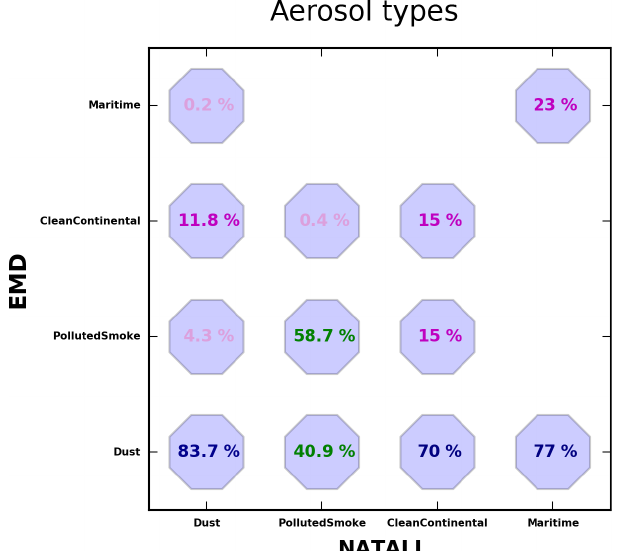
Figure 6. Typing score of each aerosol class derived by the EAR- LINET Mahalanobis distance-based typing algorithm (EMD) when applied to the NATALI modeled dataset (total of 259407 cases). The denominator in each column is the number of NATALI samples for a given type, and the numerator is the number of the EARLINET Mahalanobis distance-based classifications for the same sample.